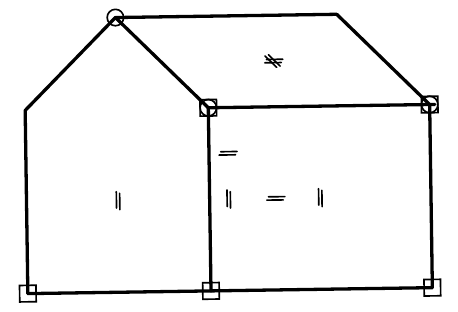
Figure 10. Line drawing after removing the auxiliary lines shown in Figure 8. The construction features 9 segments with 15 geo- metric constraints of which 9 are